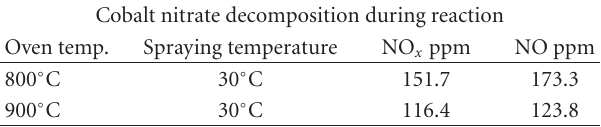
Table 2: Cobalt nitrate-acetone decomposition. Weight loss. Cobalt nitrate decomposition during